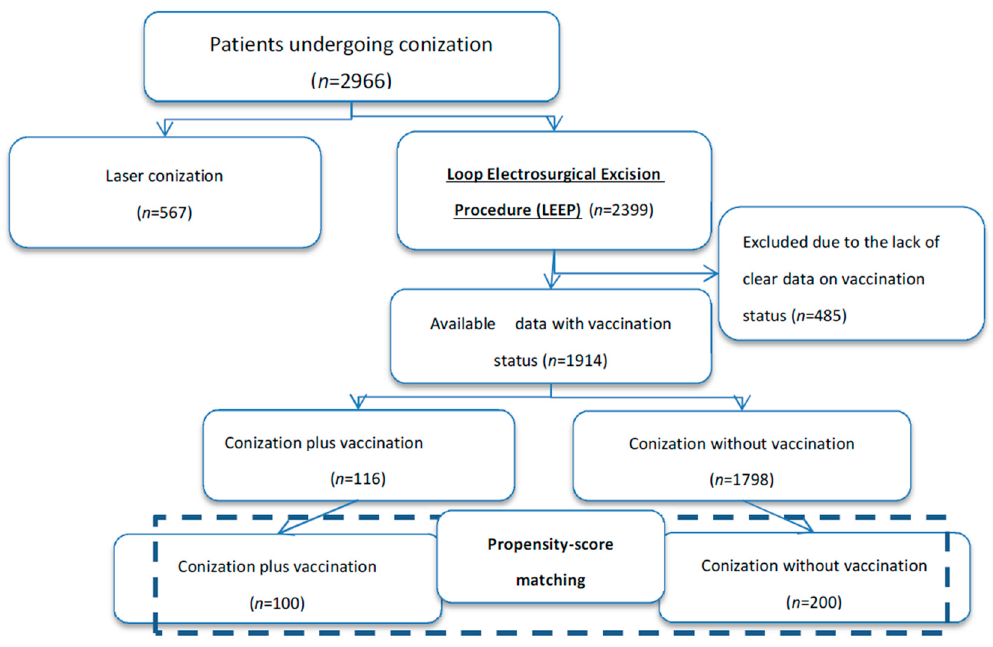
Figure 1. Study design. Table 1. Baseline characteristics of the